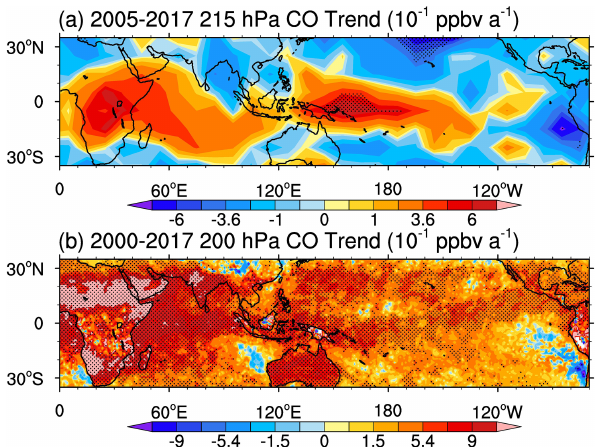
Figure 8. The trends of CO derived from the MOPITT and MLS data. (a) The trends of CO (10 − 1 ppbva − 1 ) at 215hPa, using MLS data in NDJFM during 2005–2017. (b) The trends of CO (10 − 1 ppbva − 1 ) at 200hPa, using MOPITT data in NDJFM during 2000–2017. The trends of CO over the dotted region are statistically significant at the 90% confidence